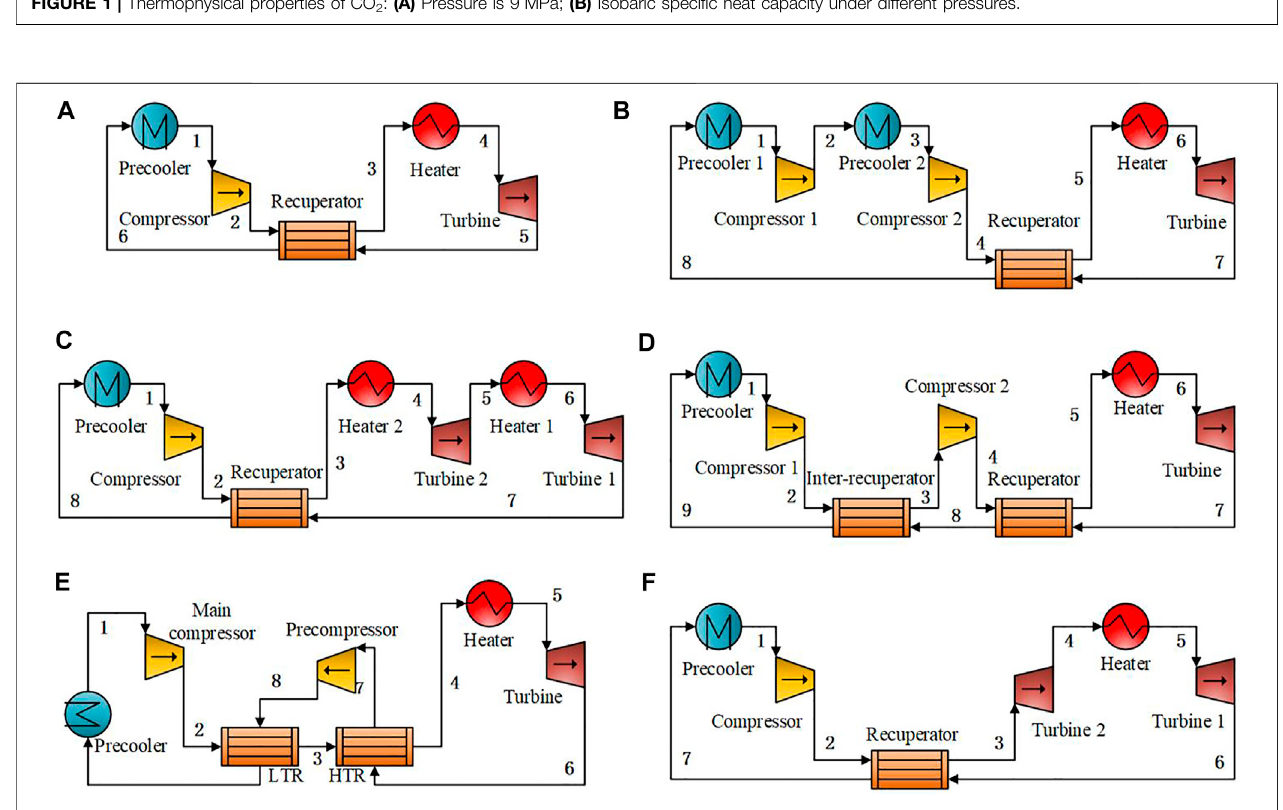
Frontiers in Energy Research |